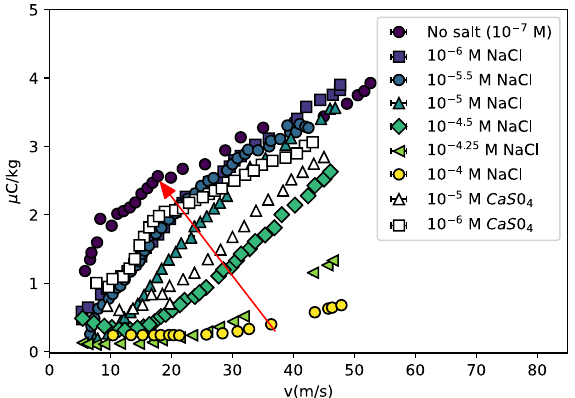
Figure 3. Charging efficiency for different salt concentrations in water. Salt changes the conductivity of the liquid as well as the electrical double layer. The arrow indicates decreasing salt concentrations (NaCl),